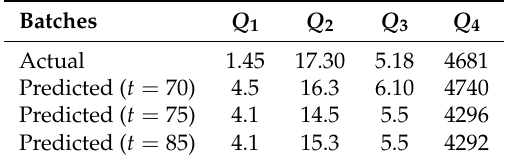
Table 2. Quality measurements predictions for validation